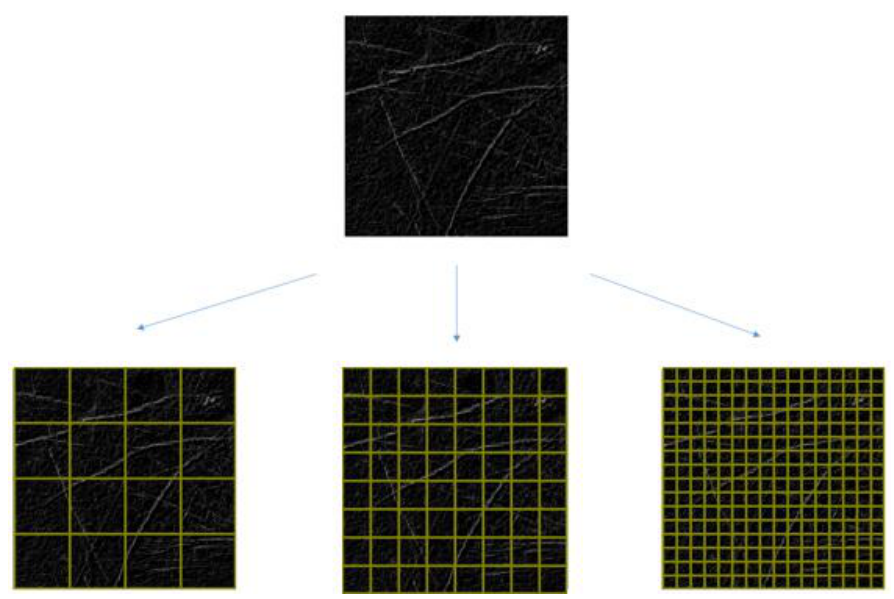
Figure 13. Example of nonoverlapping blocks.